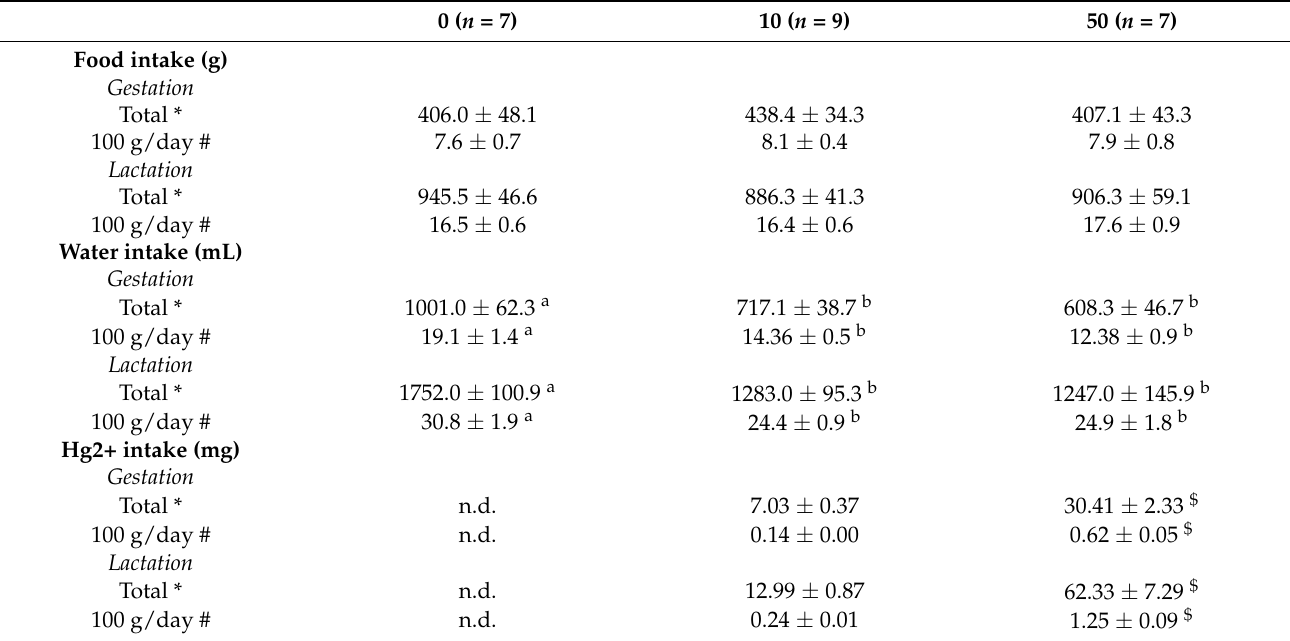
Table 1. Food, water, and Hg 2+ intake during the gestation and lactation periods of dams exposed to